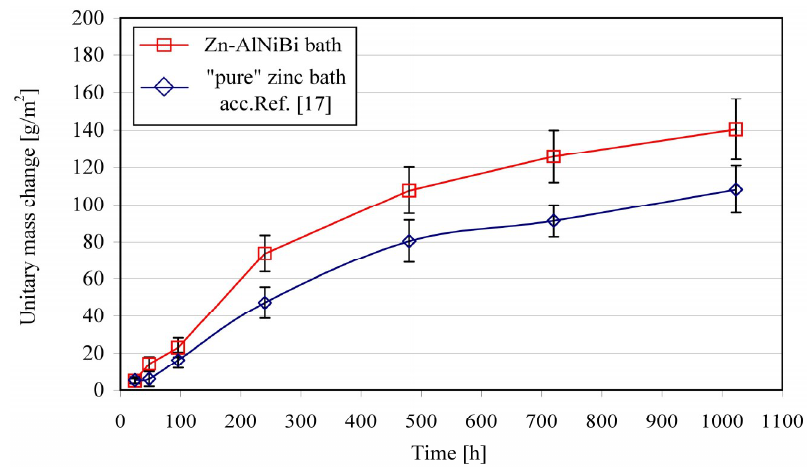
Figure 7. Unitary changes in the mass of Zn-AlNiBi and Zn coatings during the test in neutral salt